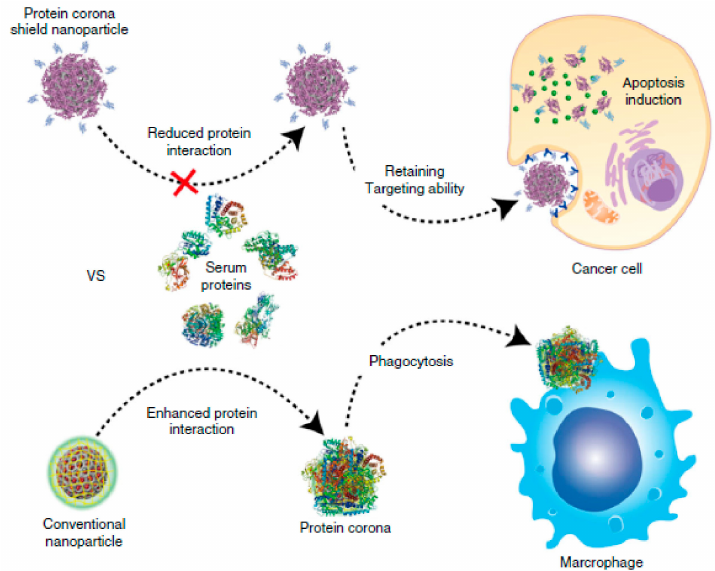
Figure 1. Schematic representation of the influence of the protein corona on the fate and performance of nanomedicines. Reprinted with permission from reference [19]. Copyright (2018) Springer